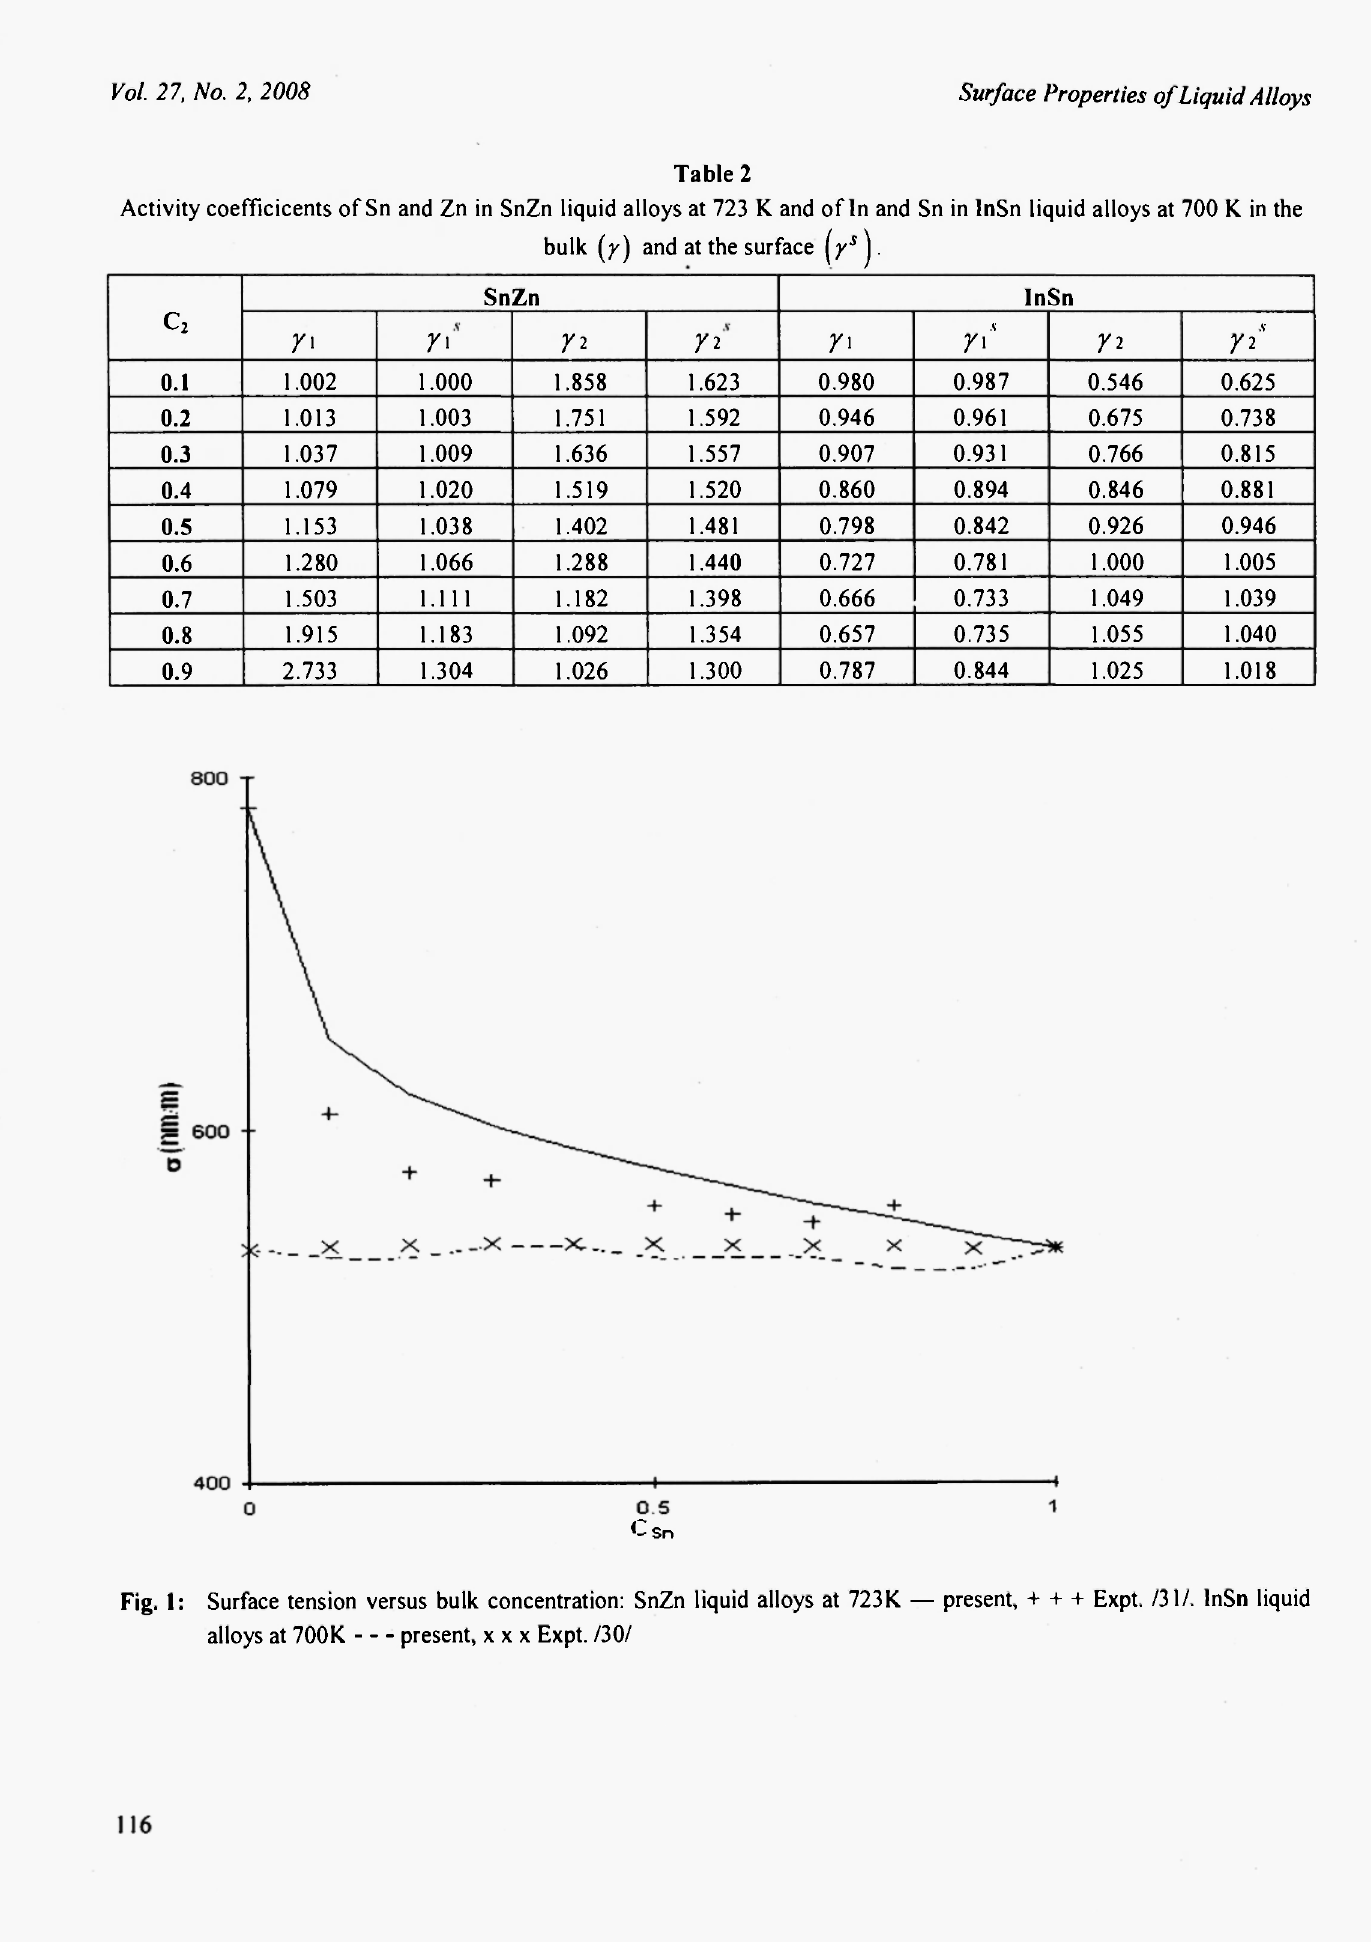
Activity coefficicents of Sn and Zn in SnZn liquid alloys at 723 Κ and of In and Sn in InSn liquid alloys at 700 Κ in the bulk (y) and at the surface [γ* j.